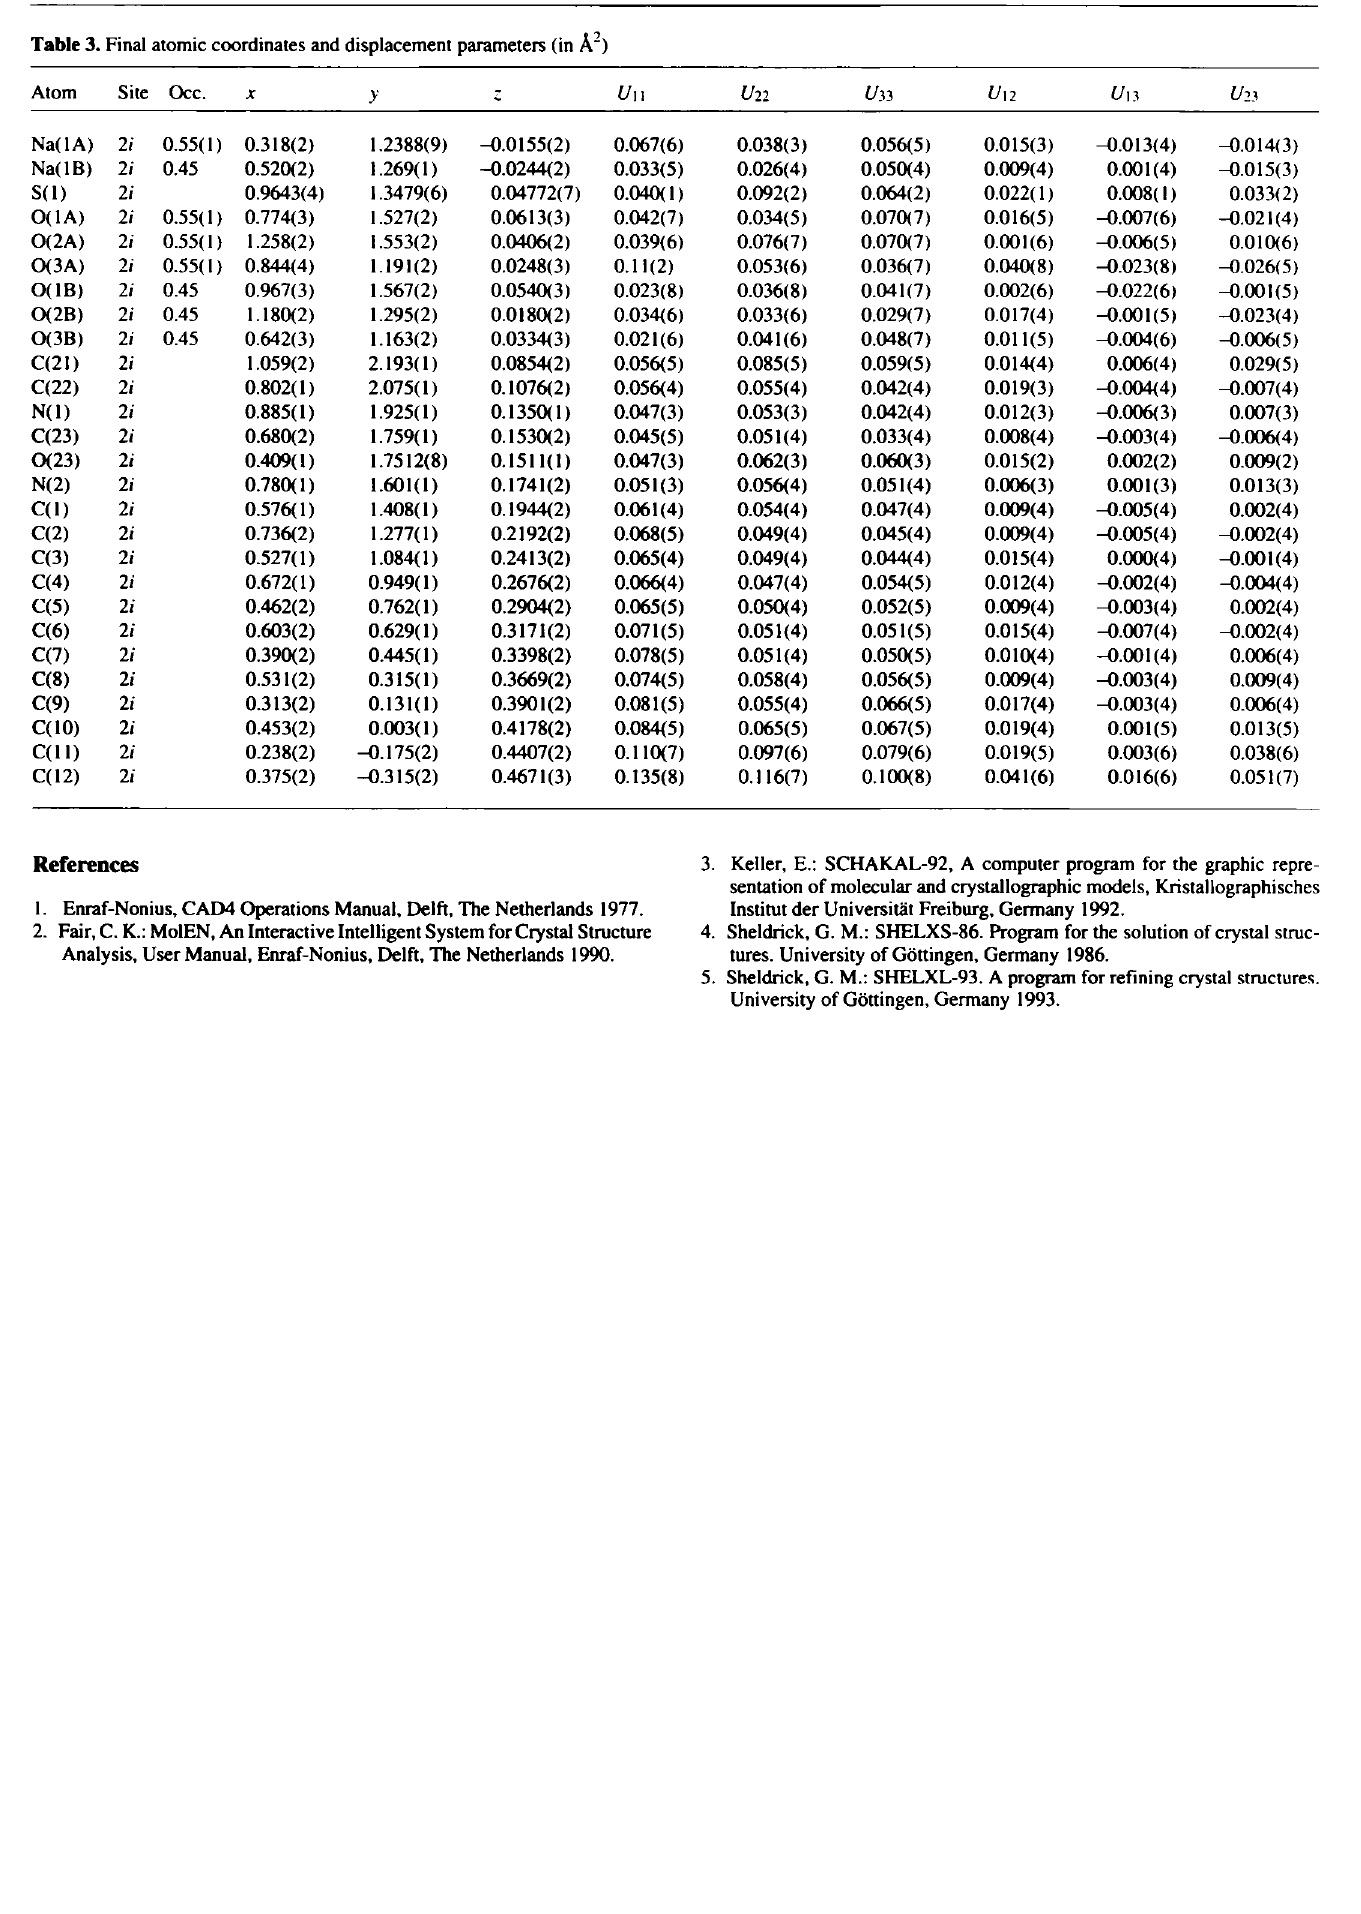
Table 3. Final atomic coordinates and displacement parameters (in